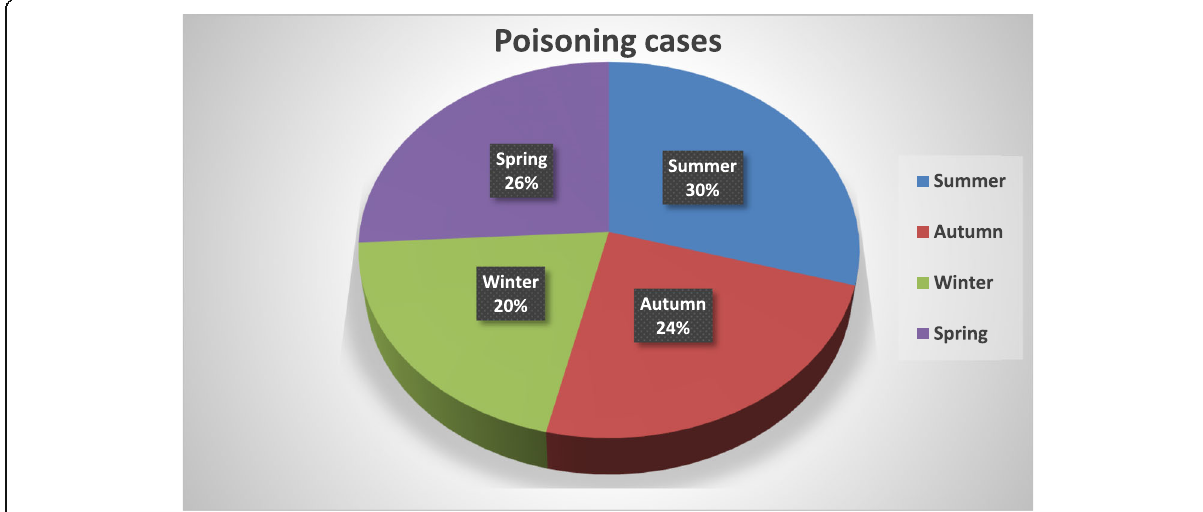
Fig. 3 Chart showing the seasonal variation of the poisoning cases